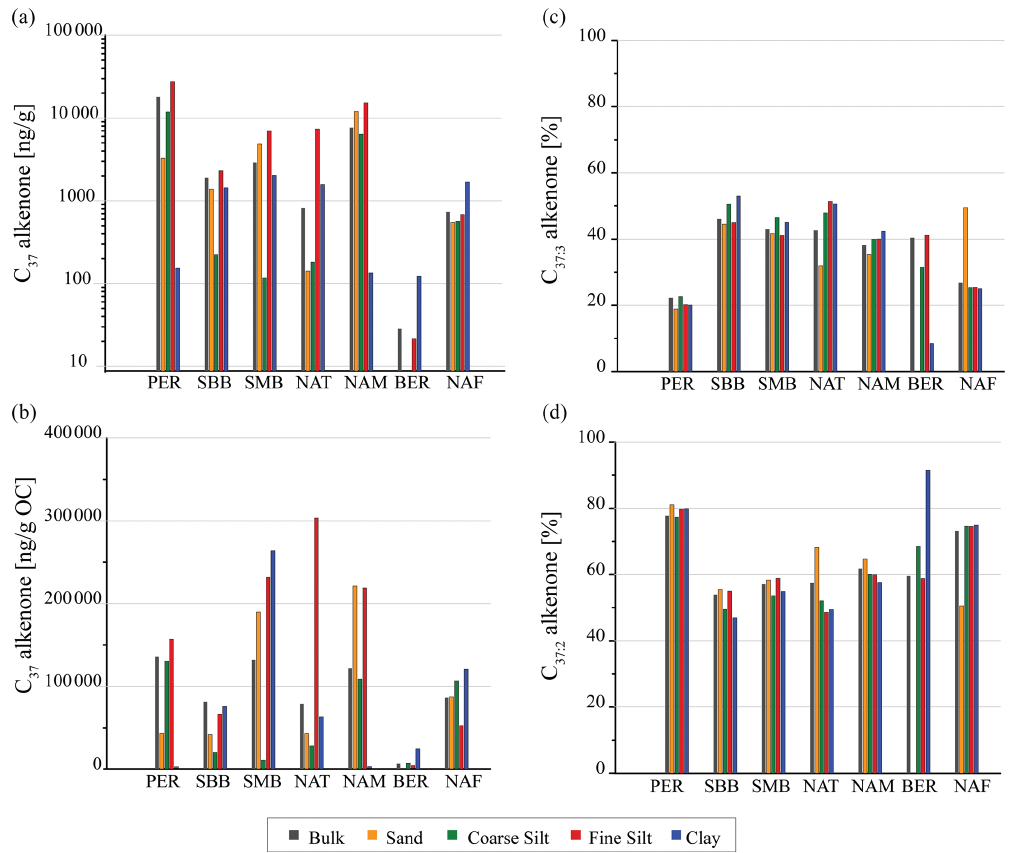
Figure 2. Alkenone concentration in bulk sediment and size fractions. (a) Total C 37 alkenone amount per gram of sediment. Abundance- weighted average concentration is indicated by black triangles, (b) total C 37 alkenone amount normalized to OC % , (c) C 37 : 3 alkenone relative amount and (d) C 37 : 2 alkenone relative amount. No sand fraction was available at BER. Table 3. Radiocarbon analyses of alkenones extracted from bulk and grain-size fractions. Measured mass, raw and corrected fraction modern ( F 14 C), corrected radiocarbon ages and corresponding 1 σ errors. Radiocarbon ages and associated 1 σ uncertainties have been rounded according to